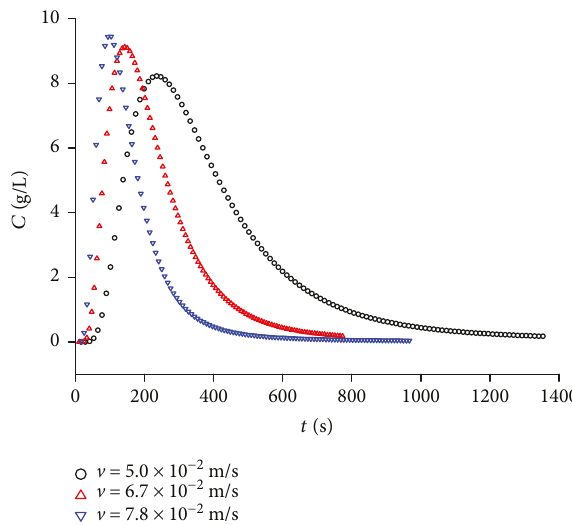
Figure 5: BTCs in fractures for the di ff erent velocities.